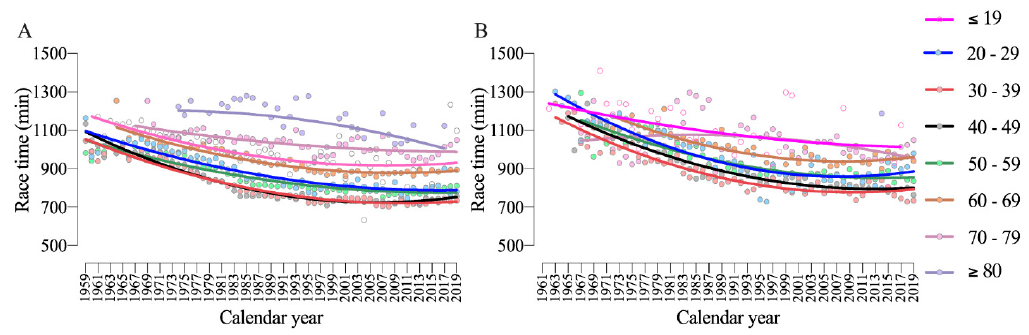
Figure 5. Performance trends of men ( A ) and women ( B ) by age groups with second-order polynomial non-linear regressions.